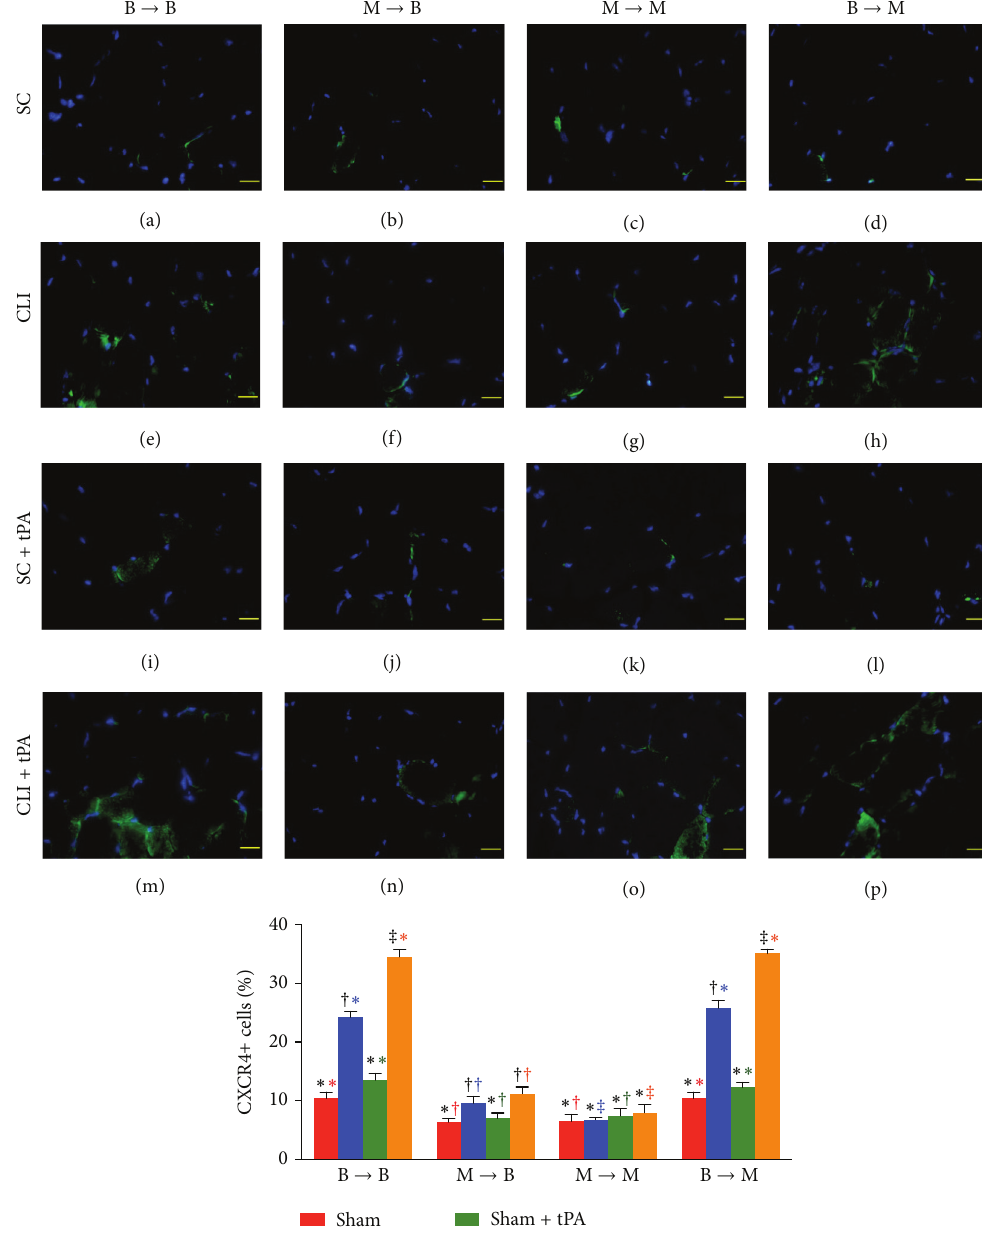
Figure 5: Immunofluorescent (IF) microscopic findings (400x) of CXCR+ cells in ischemic quadriceps at day 14 after critical limb ischemia (CLI) induction. (a–p) IF microscopic findings of CXCR4+ cells in ischemic area in four treatment conditions of four groups. (1) Statistical analysis for subgroups of each group. (1) In B → B group, subgroups with different black symbols ( ∗ , † , and ‡ ), 𝑝 < 0.05 . (2) In M → B group, subgroups with different black symbols ( ∗ , † , and ‡ ), 𝑝 < 0.05 . (3) In M → M group, 𝑝 > 0.5 . (4) In B → M group, subgroups with different black symbols ( ∗ , † , and ‡ ), 𝑝 < 0.5 . (2) Statistical analysis for group comparison with respective treatment condition. (1) For SC subgroup (red bar chart), groups with different red symbols ( ∗ , † ), 𝑝 < 0.05 . (2) For CLI subgroup (blue bar chart), groups with different blue symbols ( ∗ , † , and ‡ ), 𝑝 < 0.05 . (3) For SC + tPA subgroup (green bar chart), groups with different green symbols ( ∗ , † ), 𝑝 < 0.05 . (4) For CLI + tPA subgroup (orange bar chart), groups with different orange symbols ( ∗ , † , and ‡ ), 𝑝 < 0.05 . All statistical analyses were performed by one-way ANOVA followed by Bonferroni multiple comparison post hoc test. SC = sham control; tPA = tissue plasminogen activator. 𝑛 = 6 for each